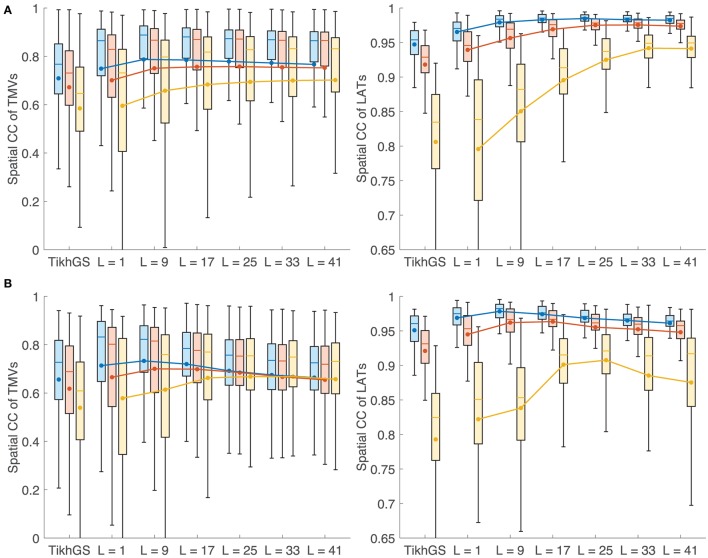
(A) Metrics for a CV of 0.4m/s. (B) Metrics for a CV of 1.2m/s. See caption of Figure 8 for details.